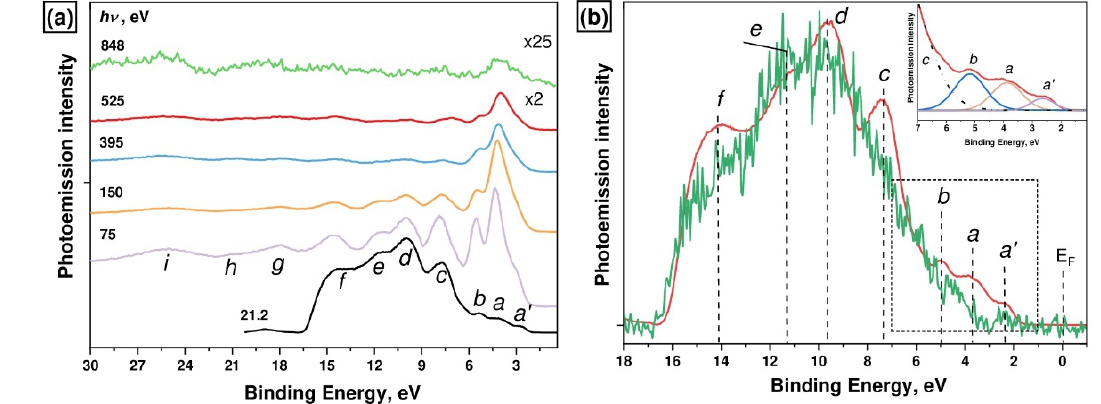
Figure 2. ( a ) VB PE spectra of the [Ni(Salen)] complex excited by photon energies h ν from 21.2 eV to 848 eV; ( b ) UV PE spectra of the [Ni(Salen)] complex (red line) and the reference H 2 Salen molecule (green line) measured with h ν = 21.2 eV. The inset shows the UV PE spectrum of the [Ni(Salen)] in the BE range from 1 to 7 eV with the fitting of components a’ , a , and b .